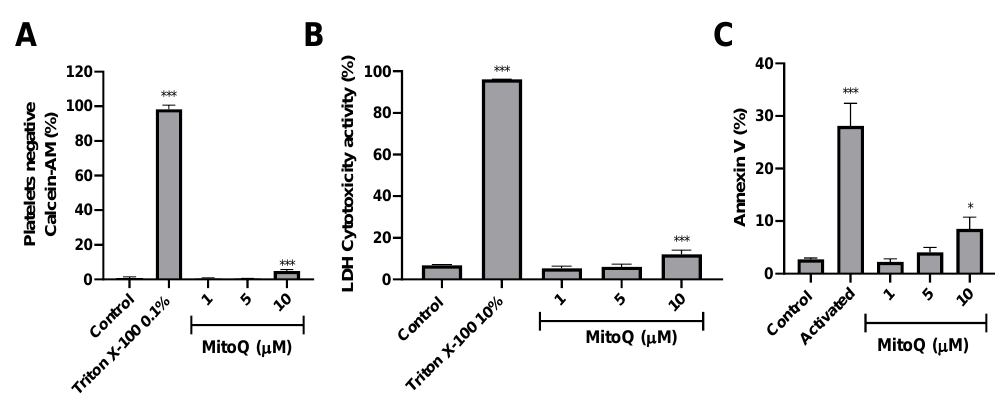
Figure 1. Cytotoxicity and phosphatidylserine exposure induced by MitoQ in platelets. ( A ) Platelet viability was evaluated by flow cytometry using calcein-AM. The populations of calcein-negative platelets (anti-CD61) were non-viable cells. ( B ) LDH release from platelets was analyzed with the LDH cytotoxicity assay kit in the supernatant and measured at 490 nm in a microplate reader. ( C ) Externalization of PS assessed by annexin-V binding in platelets stimulated by collagen plus TRAP-6 (activated) or MitoQ. ( A ) and ( C ) Platelets were identified as the CD61 + population and expressing the CD61 from these populations were analyzed in terms of percentage of the platelets with negative-calcein AM or annexin V. Representative dot plots of calcein-AM and annexin V assays were included as Supplementary Figures S1–S3. The statistical analysis was performed using the ANOVA (Tukey test). * p < 0.05, and *** p < 0.001.